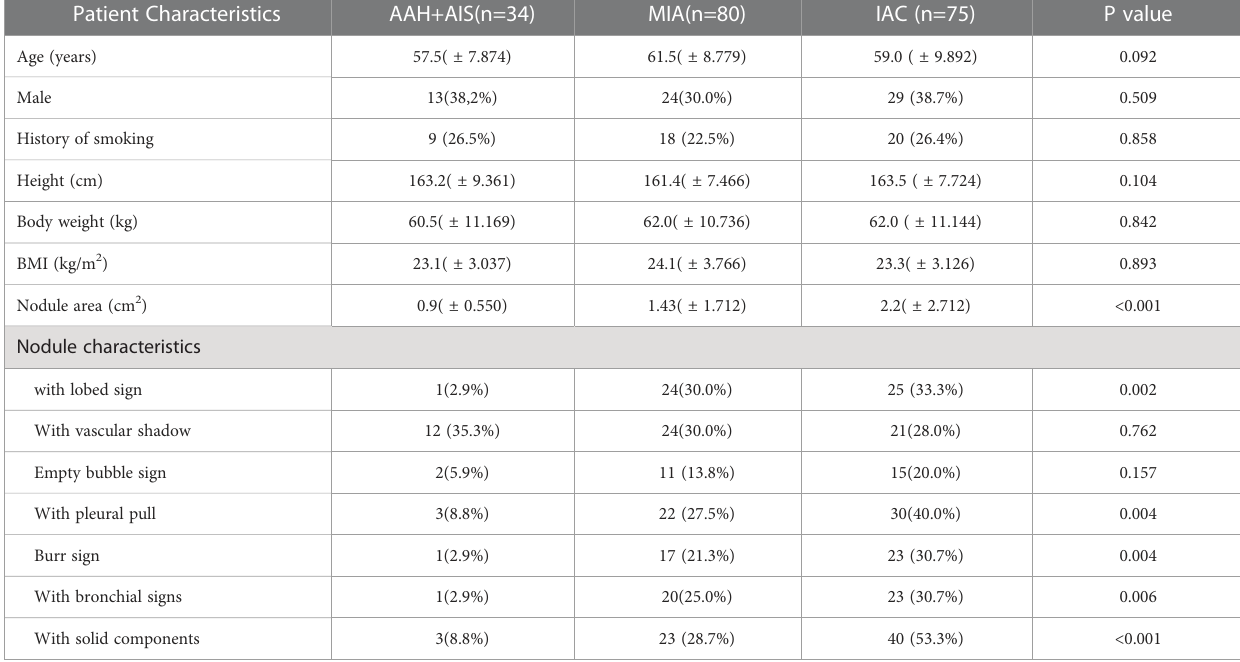
TABLE 1 Basic characteristics of patients with different pathological